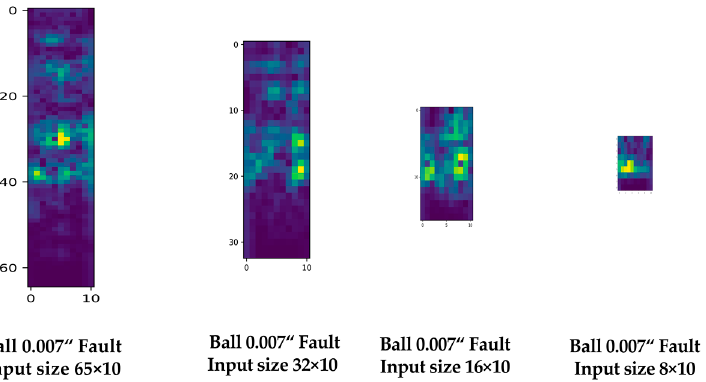
Figure 13. Examples of input spectrogram data of 65 × 10, 32 × 10, 16 × 10, and 8 × 10 sizes.